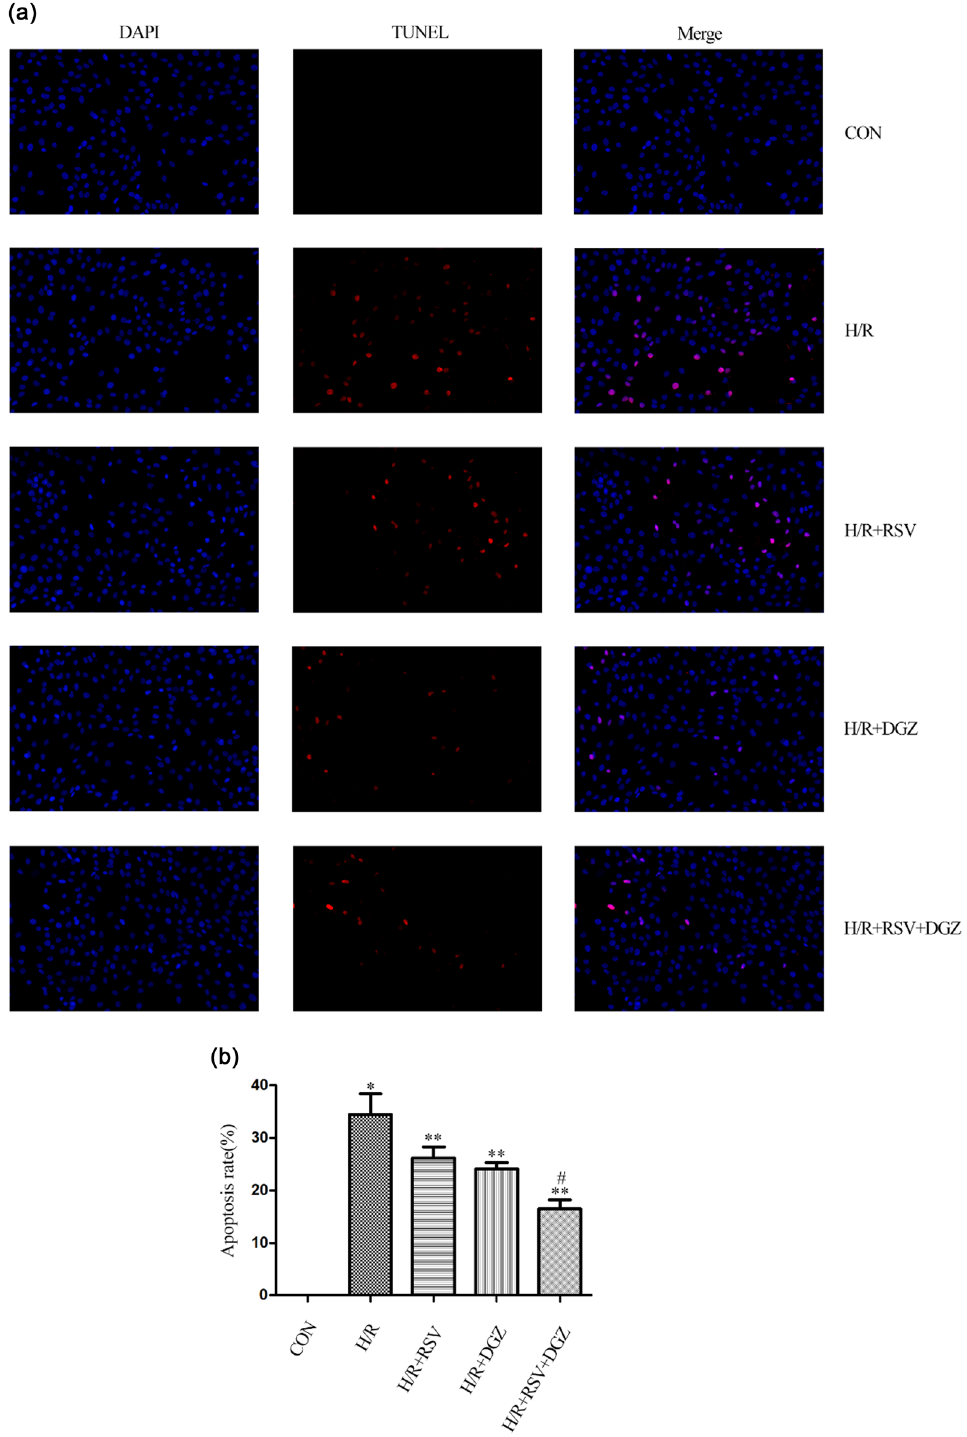
Figure 6: Protection e ff ect of RSV and DGZ against H/R - induced H9C2 cells. Cell apoptosis was assessed using TUNEL staining ( mean ± SD, n = 3 ) ( magni fi cation, × 200 ) . ( a ) Representative images of TUNEL. Apoptotic nuclei were stained with TUNEL ( red ) and total nuclei staining with DAPI ( blue ) . ( b ) Bar diagram showing the relative proportion of TUNEL - positive cells. * p < 0.001 compared with CON; ** p < 0.05 compared with H/R; # p < 0.05 compared with H/R + RSV or H/R + DGZ. CON: control group; H/R: hypoxia/reoxygenation group; H/R + RSV: hypoxia/reoxygenation + rosuvastatin group; H/R + DGZ: hypoxia/reoxygenation + dapagli fl ozin group; H/R + RSV + DGZ: hypoxia/ reoxygenation + rosuvastatin + dapagli fl ozin